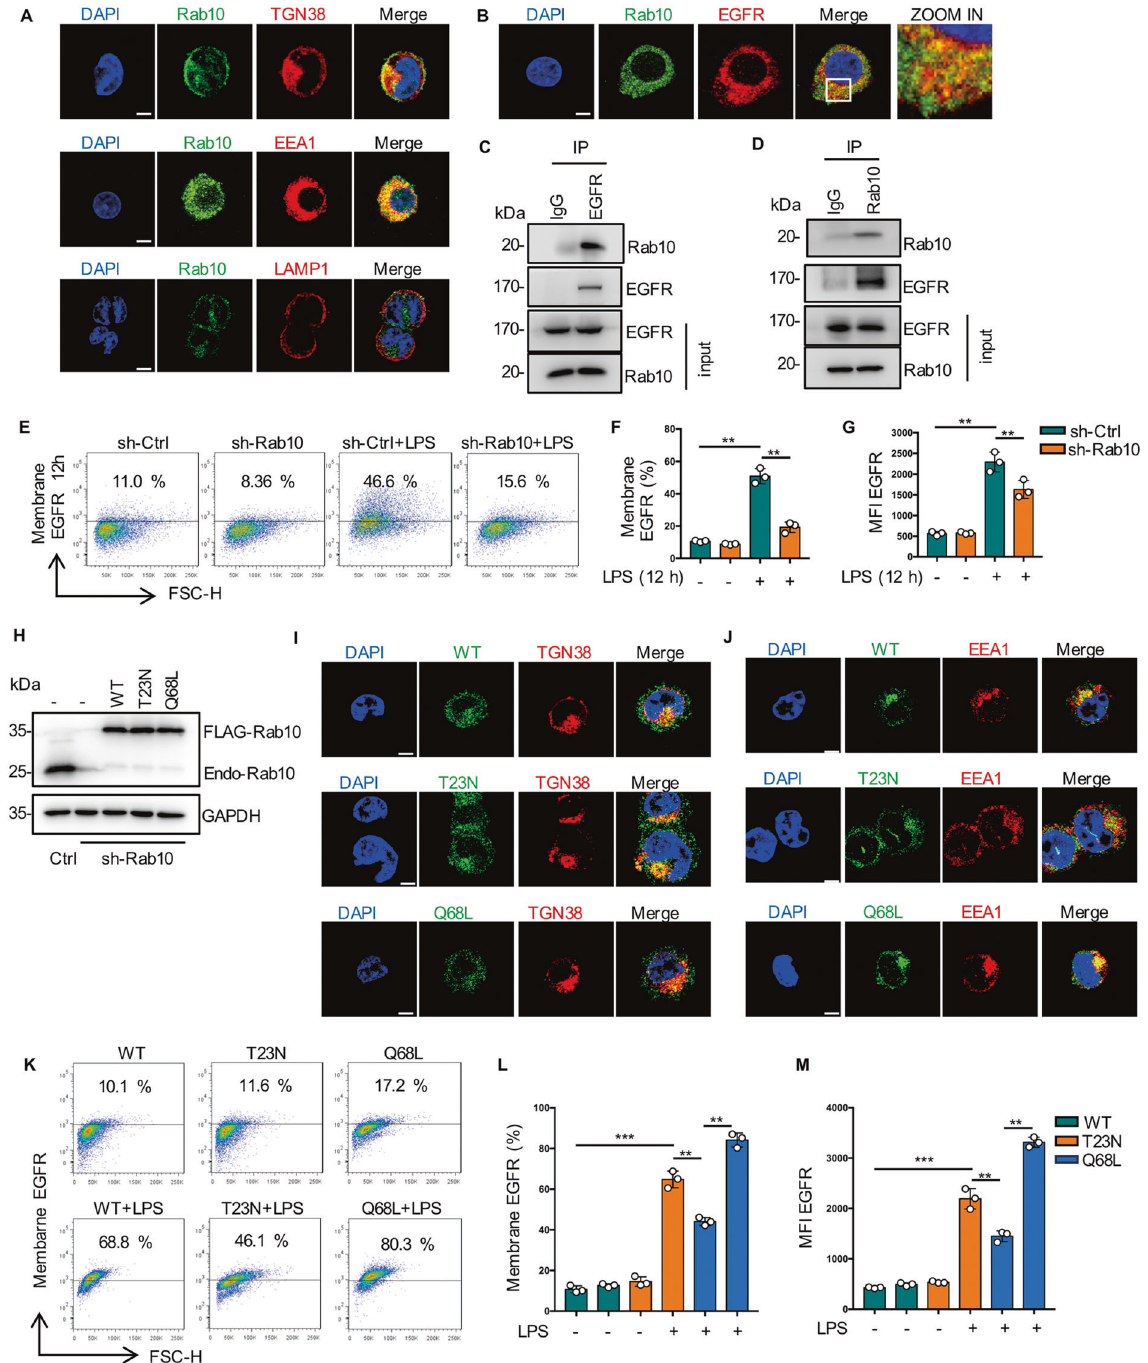
Fig. 5 Rab10 helps surface expression of EGFR in macrophages. A EGFR is localized to Rab10-positive Golgi and early endosomes compartments. RAW2654.7 cells were immunostained with anti-TGN38K (red), anti-EEA1 (red), or anti-LAMP1 (red) and anti-Rab10 (green) Abs. Representative confocal images show colocalization (yellow) of Rab10 and TGN38K, EEA1, LAMP1. Scale bar, 5 μ m. B Rab10 colocalized with EGFR in RAW264.7 cells. Scale bar, 5 μ m. C Immunoblot analysis of EGFR immunoprecipitates of lysates of RAW264.7 cells. D Immunoblot analysis of Rab10 immunoprecipitates of lysates of RAW264.7 cells. E – G Sh-ctrl and sh-Rab10 BMDM were treated with LPS (1 μ g/mL) for 12 h. E EGFR expression on the surface of BMDM was analyzed by fl ow cytometry. F Percentage of EGFR-positive BMDM is shown ( n = 3). G Mean fl uorescence intensity (MFI) is shown ( n = 3). H Stable expression of Rab10-WT, Rab10-T23N or Rab10-Q68L mutant in Rab10 shRNA knockdown RAW264.7 cells. Immunoblotting of whole-cell extracts from the indicated cells using a-Rab10 or a-GAPDH as a loading control. I Immune-staining of TGN38 and indicated mutations of Rab10 in RAW264.7. J Immune-staining of EEA1 and indicated mutations of Rab10 in RAW264.7. K – M The indicated Rab10 mutant RAW264.7 cells were stimulated with LPS for 12 h. K EGFR expression on the surface of BMDM was analyzed by fl ow cytometry ( n = 3). L Percentage of EGFR-positive BMDM is shown ( n = 3). M Mean fl uorescence intensity (MFI) is shown ( n = 3). The graphs depict mean ± SD based on three independent experiments. * P < 0.05, ** P < 0.01, *** P < 0.001.